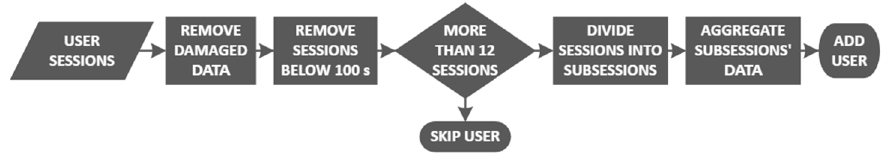
Figure 2. The user choice rules pipeline.